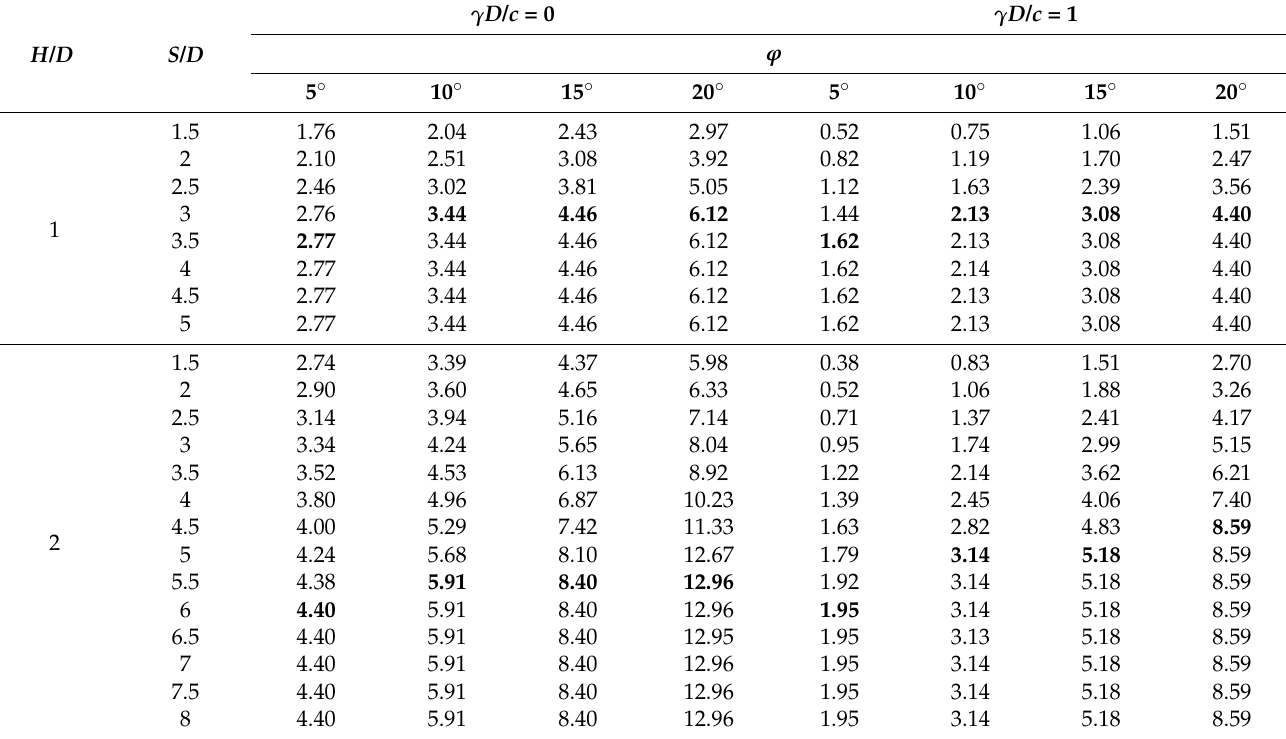
Table 1. Seismic bearing capacity N cs with k h =